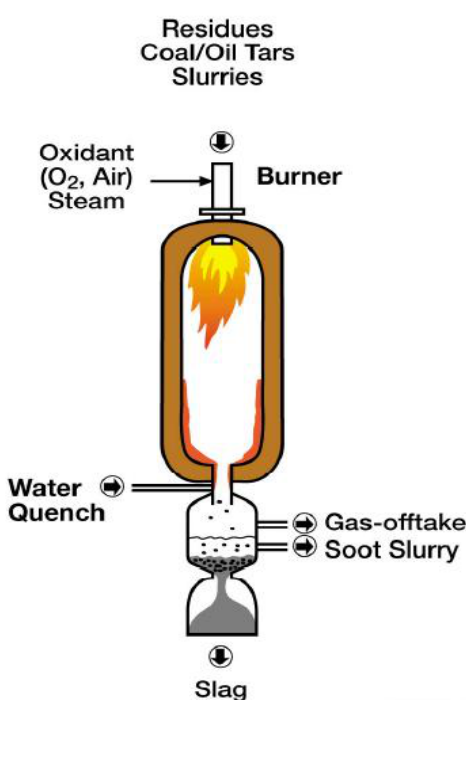
Figure 12. Lurgi Multi Purpose Gasifier